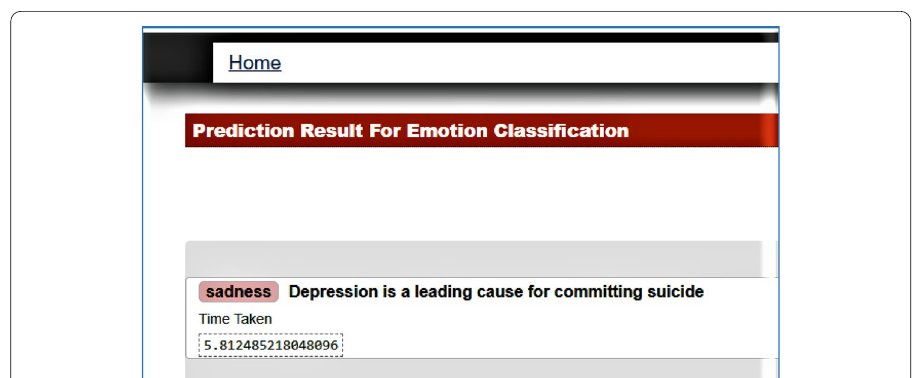
Fig. 25 Sadness Tweet with the time taken 5 s